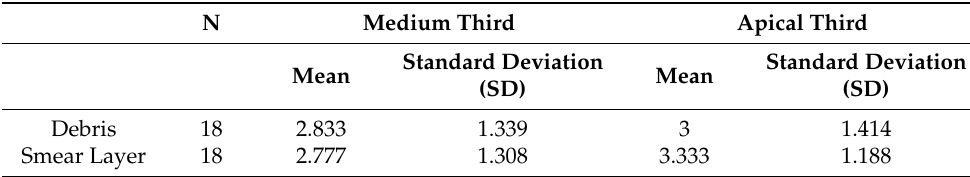
Figure 2. Means and standard deviations of debris and smear layer scores in the medium and apical third of the root canal. Table 3. Debris and smear layer scores in the medium and apical thirds of the root canal (mean and SD).